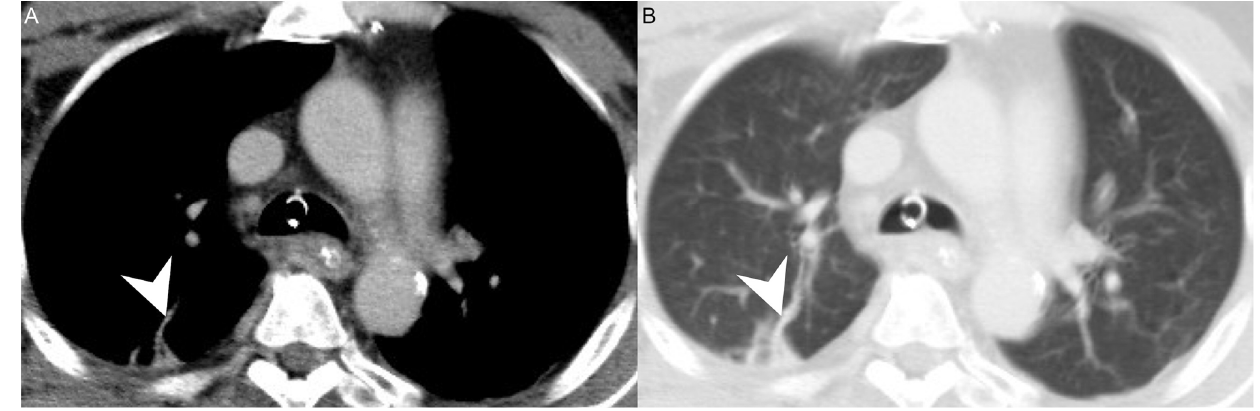
Figure 2. ( A ) CT axial view and ( B ) lung window of a patient with concurrent DNI and LS. Arrow- head: septic emboli.